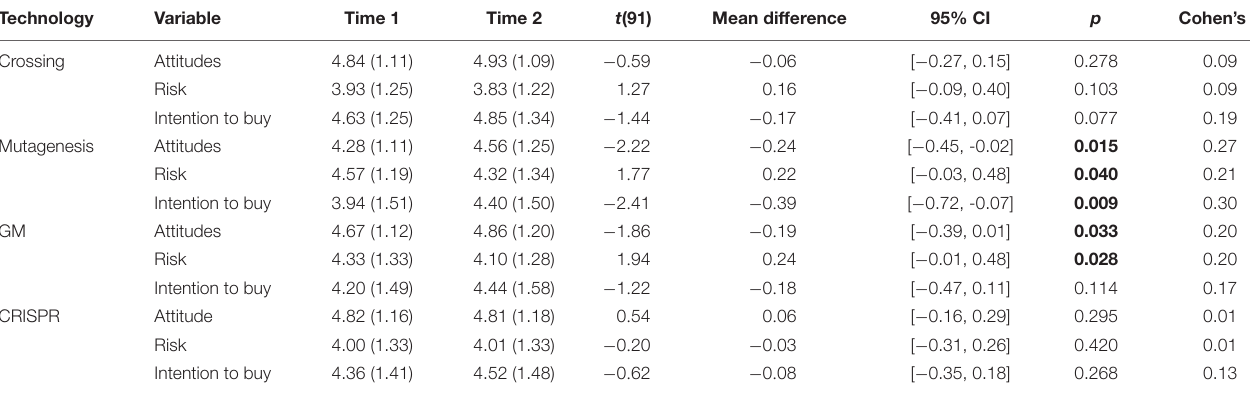
TABLE 1 | One-tailed t -tests comparing the means (SDs within parentheses) for attitudes, risk, and intention at Time 1 and Time 2. Technology